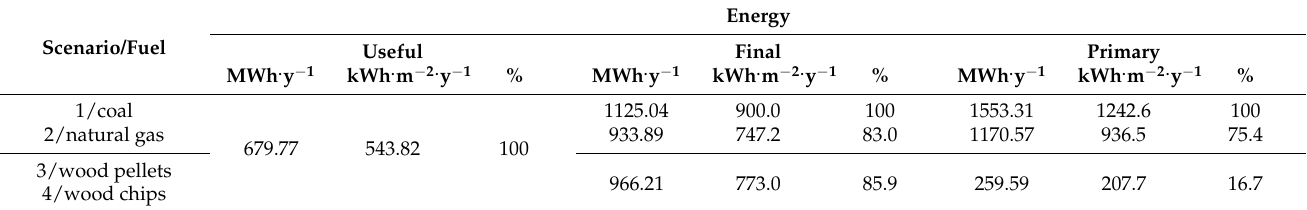
Table 5. Energy performance of the GH.